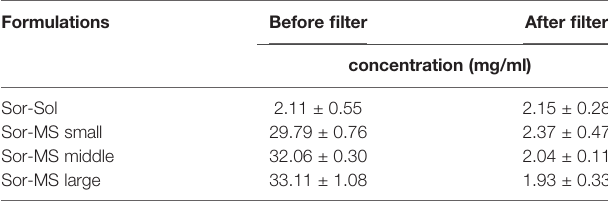
TABLE 1 | The concentrations of sorafenib in the formulations. Formulations Before fi lter